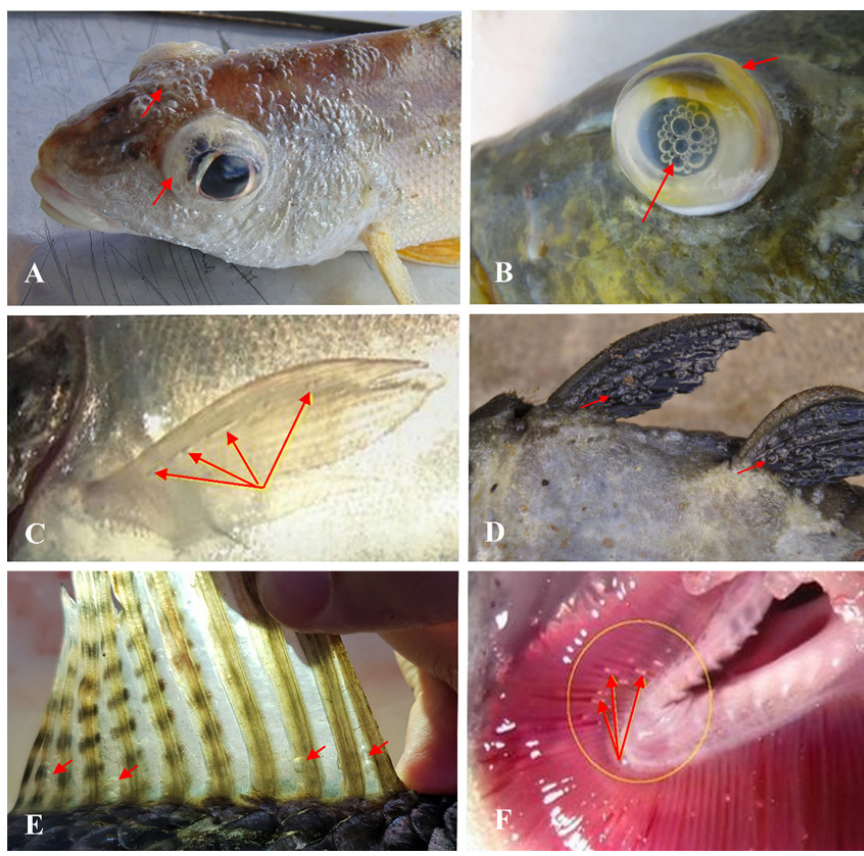
FIGURE 2 | Indication of gas bubble disease in fish downstream from spillways, with bubbles in integument ( A ), eyeball ( B ), exophthalmos ( A , B ), along with the rays of the pectoral ( C , D ) and dorsal fins ( E ) and in the gill filament ( F